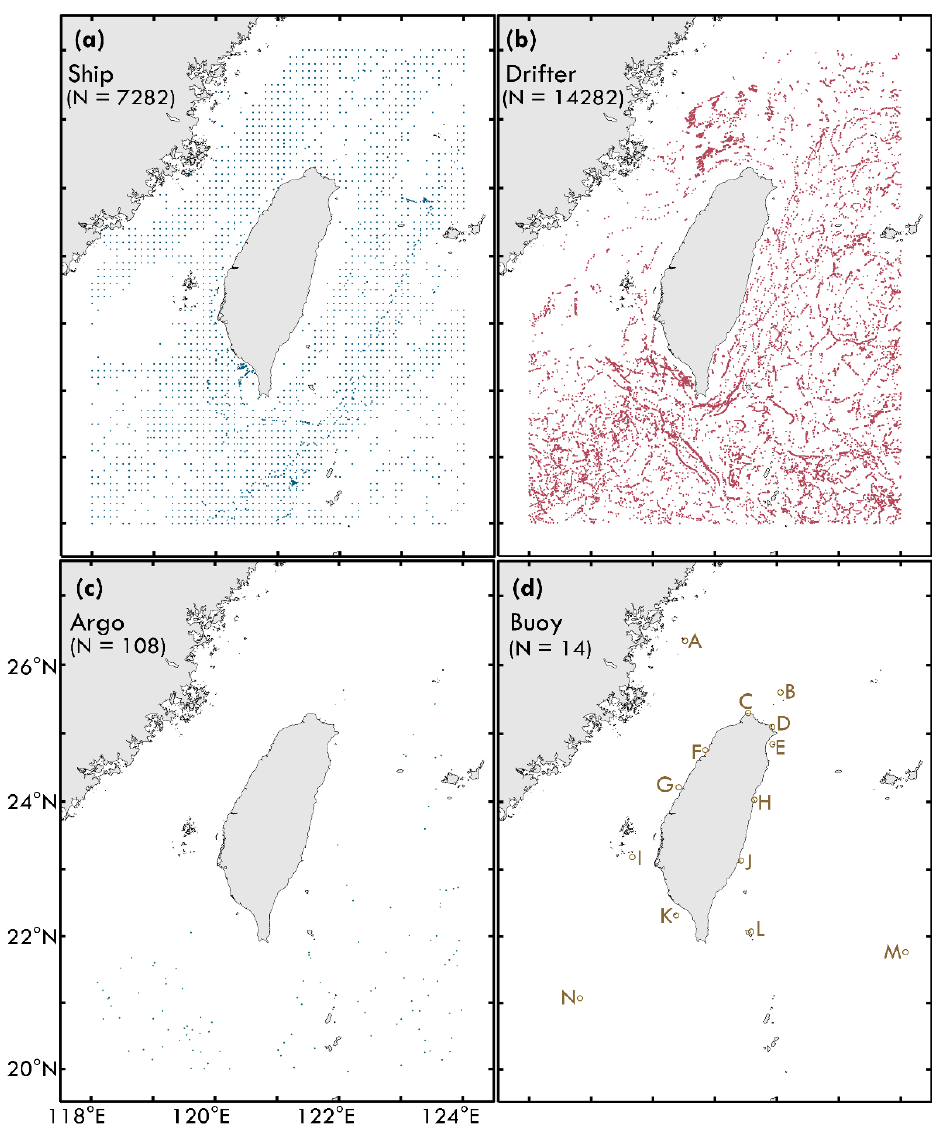
Figure 2. The spatial distribution of four kinds of in situ observation data. (a) Ship, (b) drifter, (c) Argo, and (d) buoy.